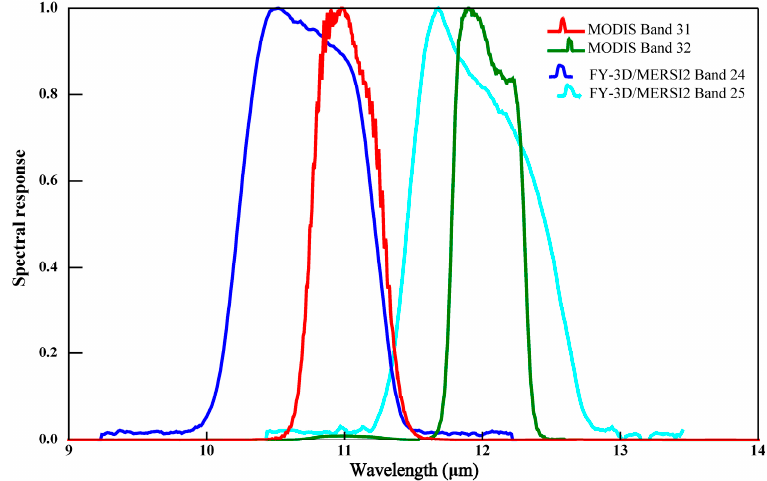
Figure 1. Spectral response functions of the MERSI-2 and MODIS TIR channels. Table 1. Comparison of Medium Resolution Spectral Imager II (MERSI-2) with Moderate Resolution Imaging Spectroradiometer (MODIS), MERSI, and Visible Infrared Imaging Radiometer Suite (VIIRS) in partial bands.